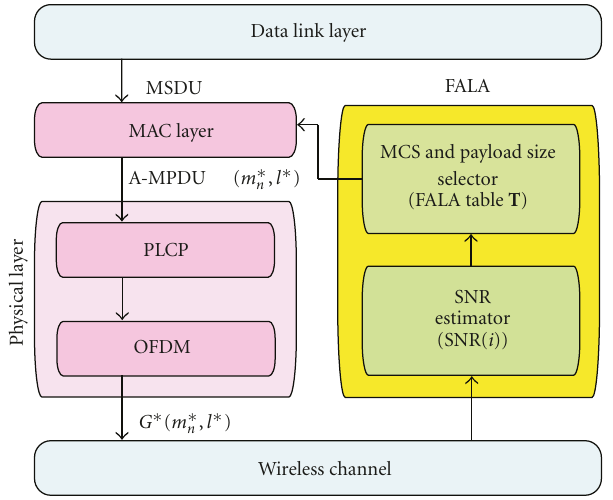
Figure 4: The system architecture for the proposed FALA algo-